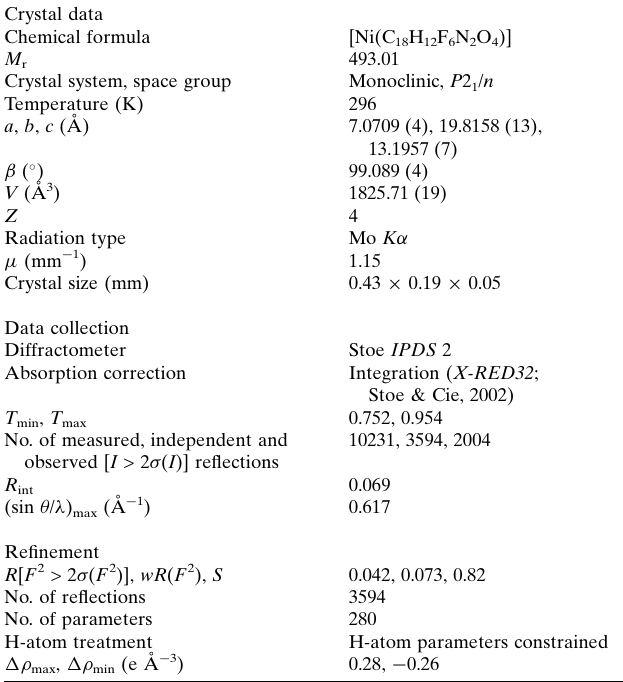
Table 1 Experimental details. Crystal data Chemical